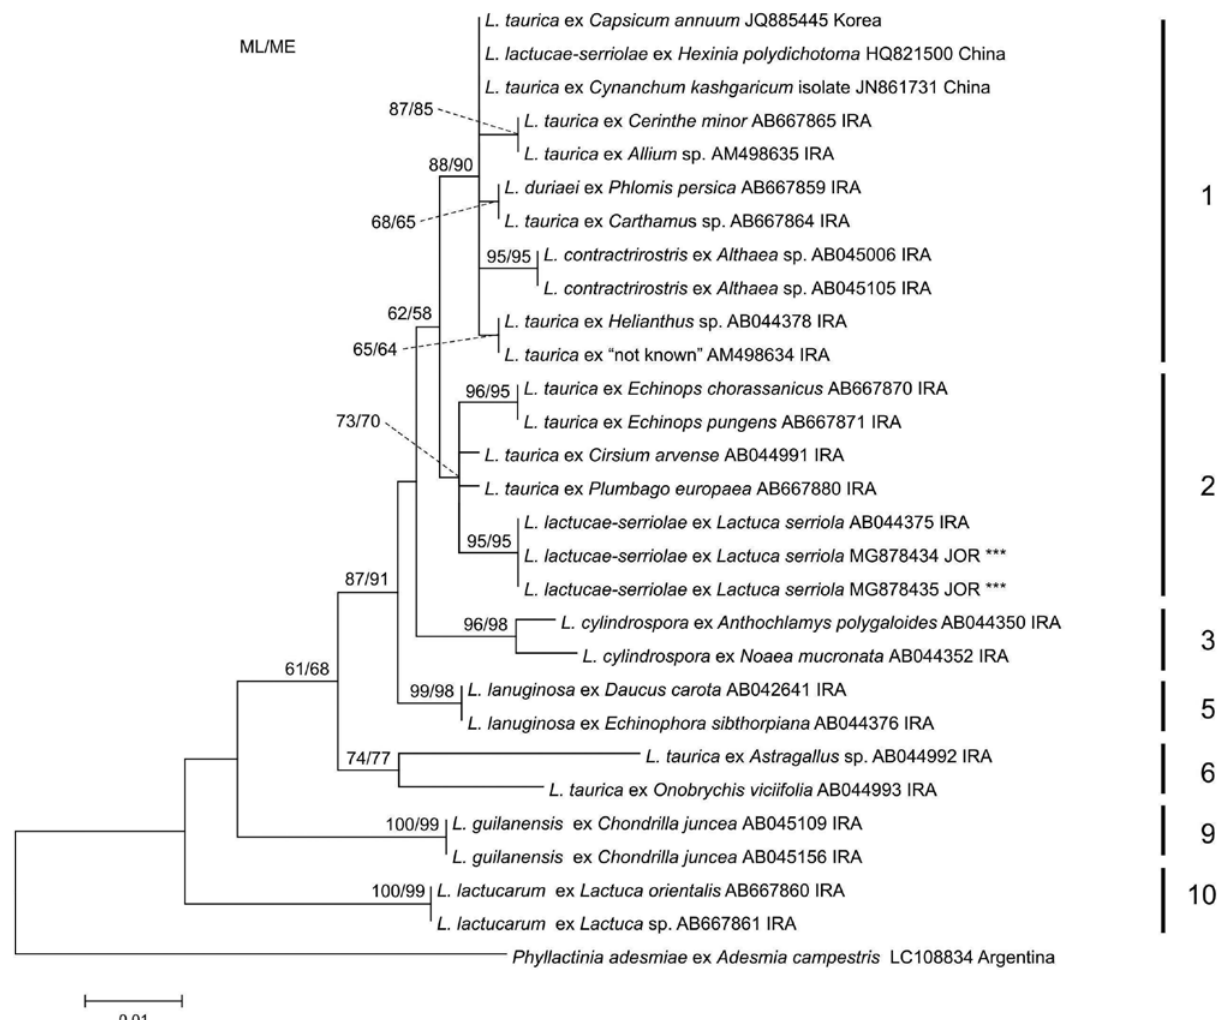
Figure 3. Maximum-Likelihood tree based on ITS nucleotide sequences of 28 taxa of Leveillula and single outgroup taxa. Numbers above branches indicate bootstrap values based on 1000 replications of ML and ME phylogeny (Bootstrap values less than 50% are not shown). Numbers to the right indicate the clades designated by Khodaparast et al . (2012). *** indicates specimens analysed in the present